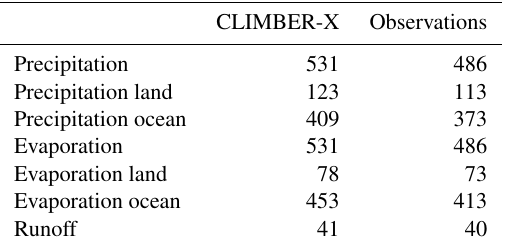
Table 2. Global hydrological cycle in CLIMBER-X compared